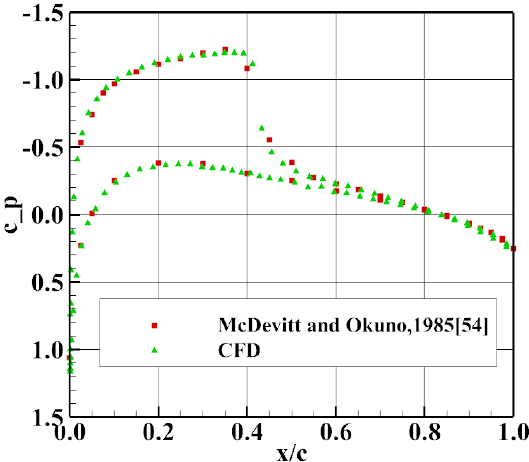
Figure 2. Comparison of numerical and test results.